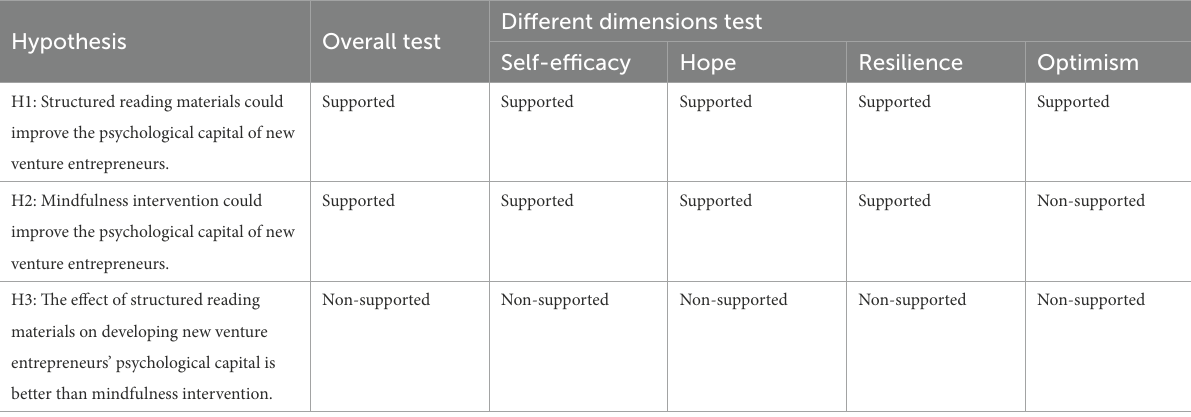
TABLE 10 Hypothesis test